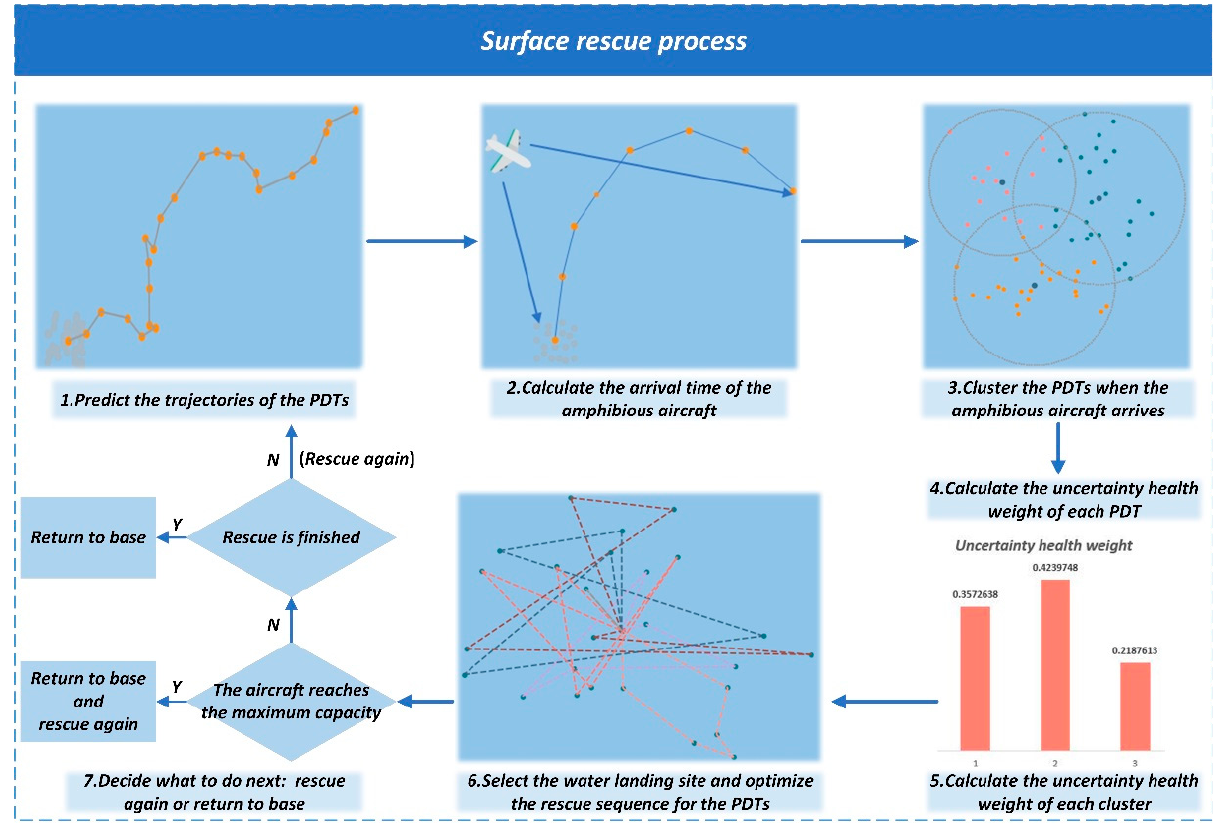
Figure 1. The surface rescue process of amphibious aircrafts based on TPM for medium/distant maritime rescue.